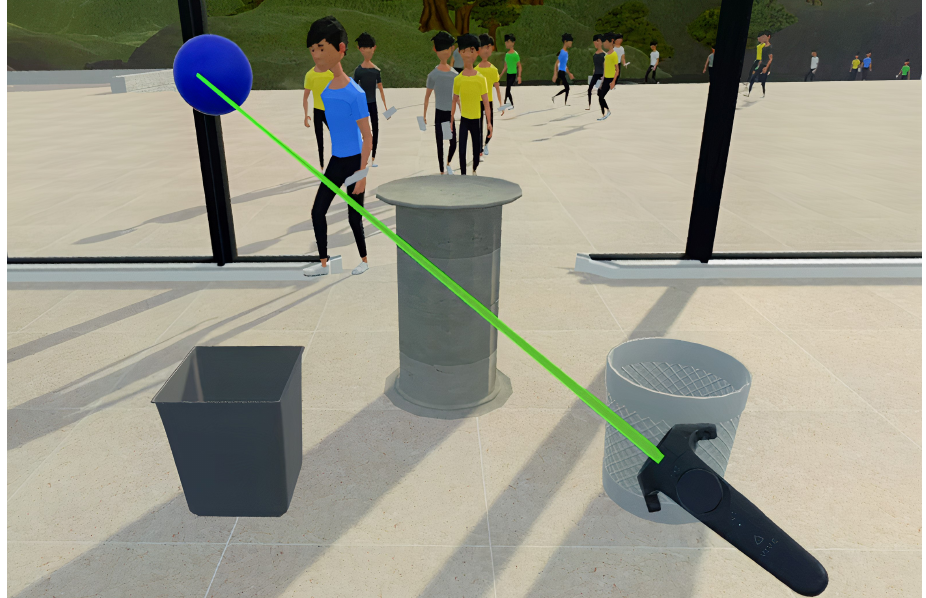
Figure 1. Game view capture of a single trial of the VR n-back ( n = 1) and the visual detection tasks. Participants were required to place a sphere into the corresponding bucket. If the sphere matched the color of the previous sphere one step before, participants placed it into the right bucket. If not, the sphere had to be placed into the left bucket. The visual detection task required participants to monitor if visitors of a museum either possessed a ticket to enter the building or not. To signal a missing ticket after detection, the participant had to select the NPC (see Supplymentary